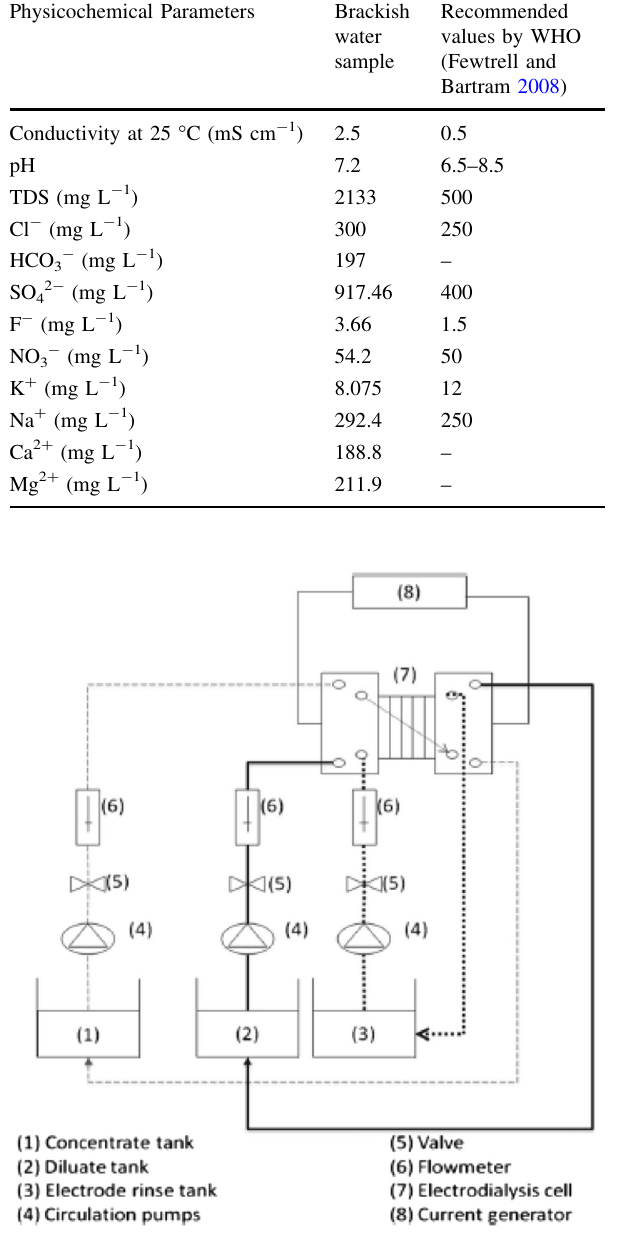
Fig. 1 Scheme of the ED installation